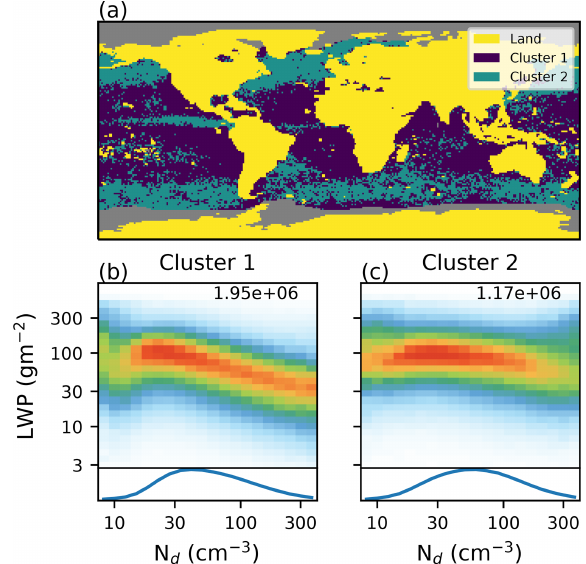
Figure 3. (a) The location of the oceanic clusters for the N d –LWP relationship, determined using the k-POD clustering method, us- ing MODIS N d and the AMSR-E in-cloud LWP. Panels (b) and (c) show N d –LWP joint histograms for the two clusters (as in Fig. 2) The line plot at the bottom shows the occurrence of each N d value for each cluster, and the number of retrievals assigned to each clus- ter is displayed in the upper right of each